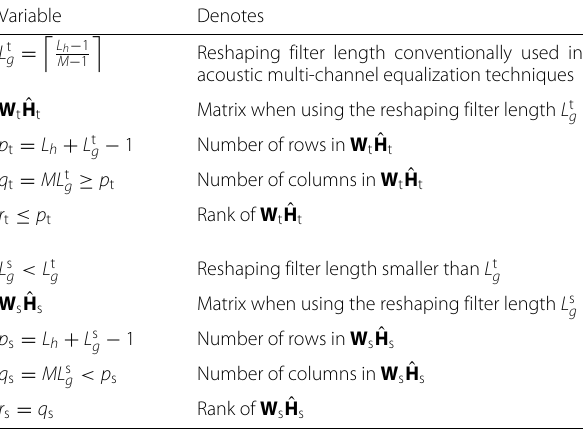
Table 2 Notation for different reshaping filter lengths and